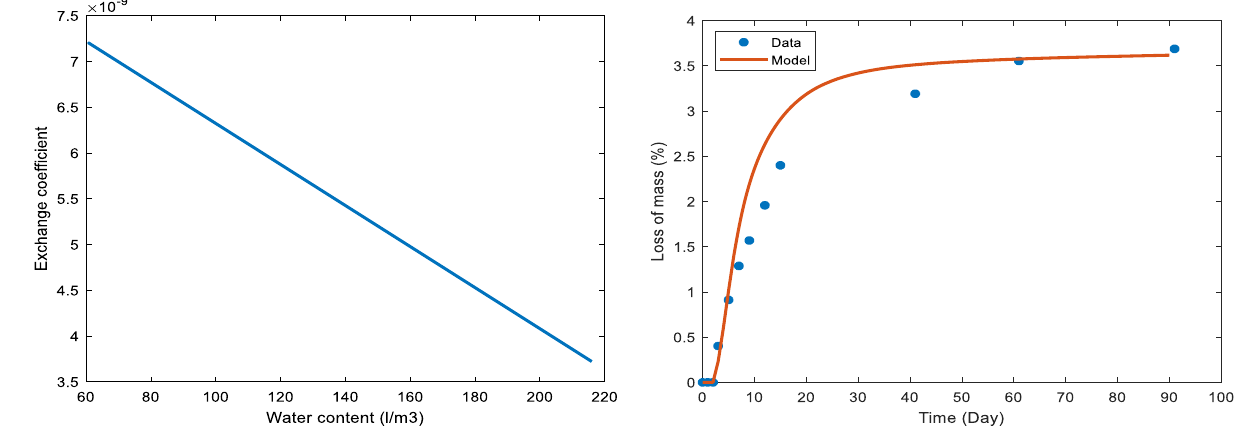
Figure 5: Exchange coe ffi cient.